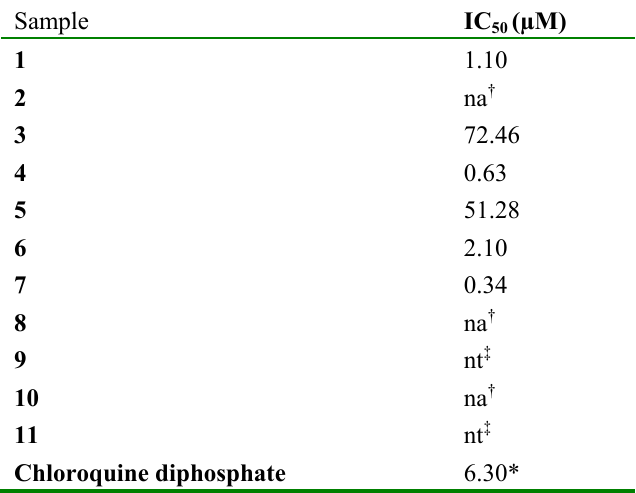
Table 2. Antimalarial Activities of Anthraquinones from R. elliptica